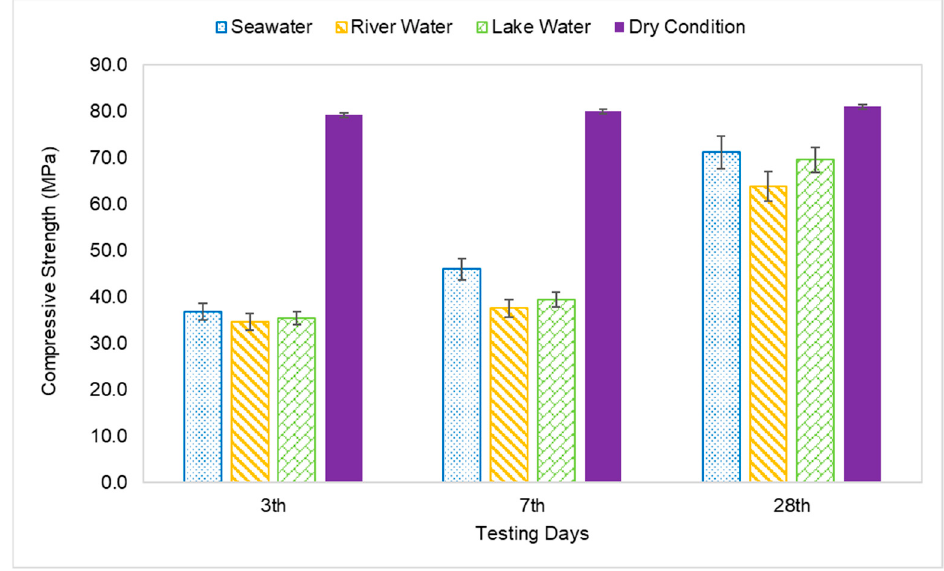
Figure 4. Compressive strength of AAFA paste cast in